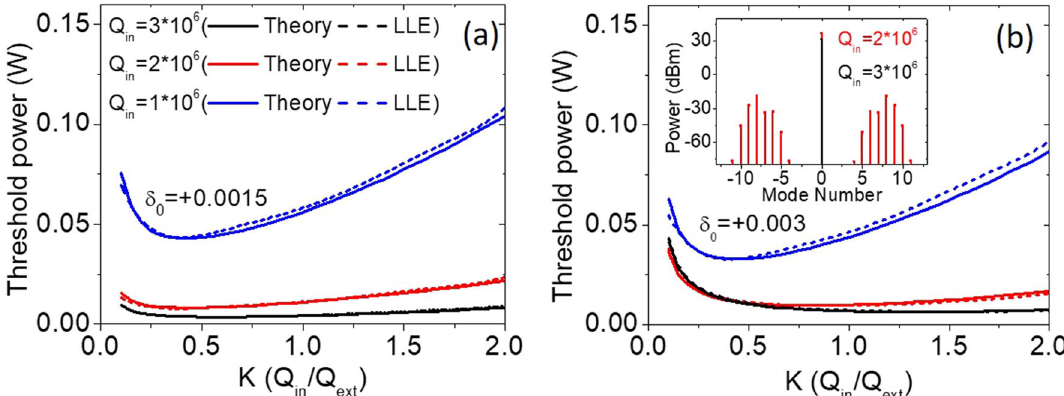
Figure 4. Simulated threshold for resonators with Q in = 1, 2, and 3 million. The detuning is set at ( a ) δ 0 = + 0.0015 and ( b ) δ 0 = + 0.003. Solid lines stand for the simulated results from the traveling wave theory while the dashed lines stand for that from the